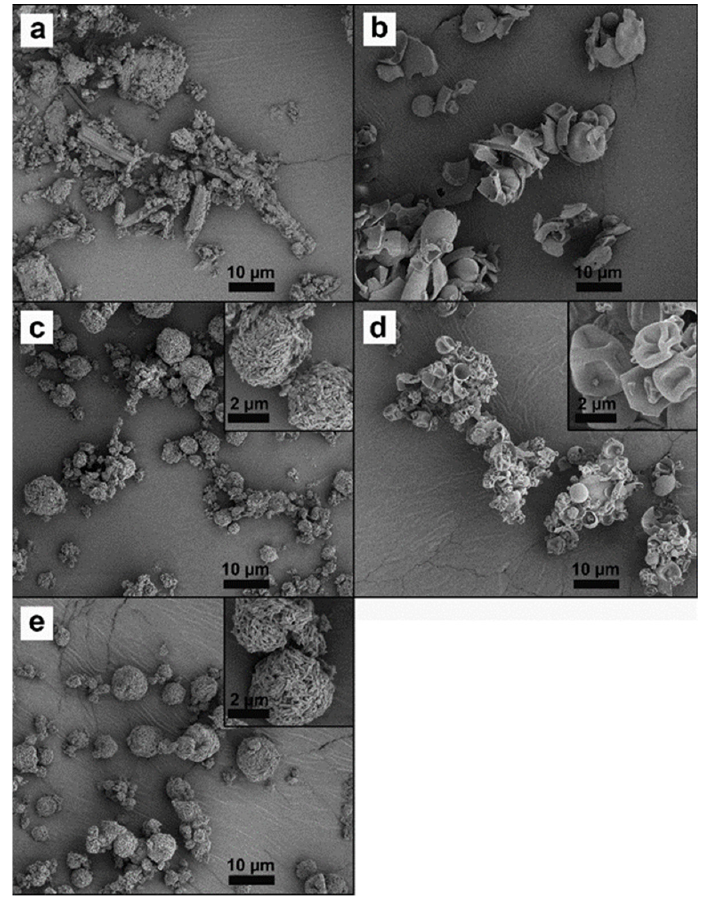
Figure 2. SEM pictures of raw CIP ( a ), raw PMB ( b ), CIP − SD ( c ), PMB − SD ( d ) and PMB − CIP − SD ( e ). Table 4. Particle sizes of dry powder formulations.